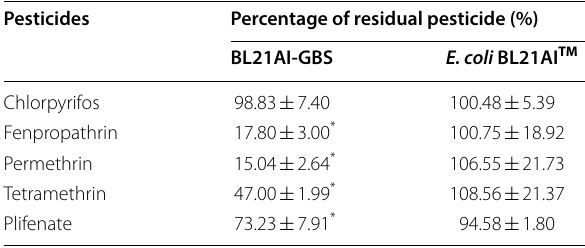
* P < 0.05, compared with that of control bacteria E. coli BL21AI